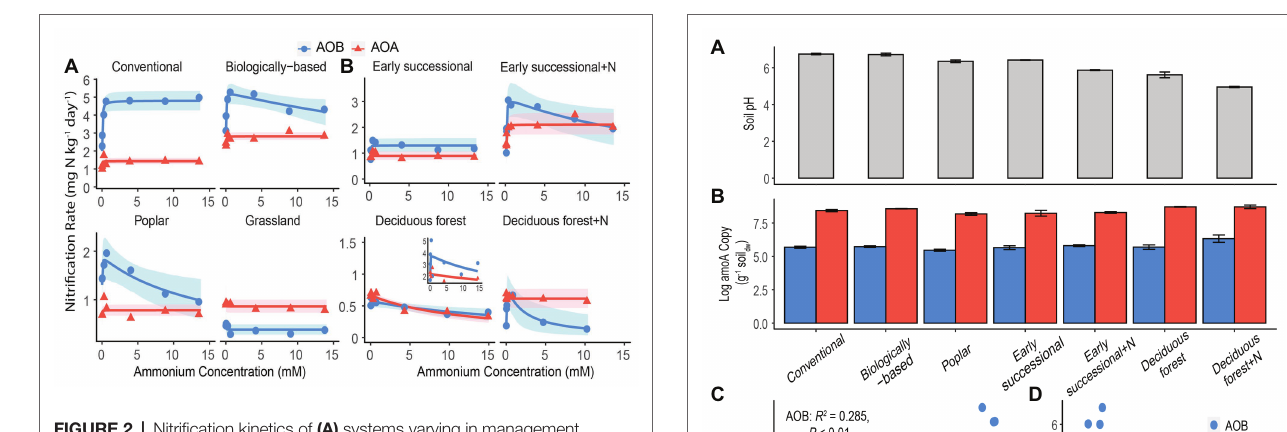
FIGURE 2 | Nitrification kinetics of (A) systems varying in management intensities and (B) unmanaged systems with (+N) or without long-term N fertilization; Michaelis-Menten or Haldane models were fit to AOB-derived (blue line) and AOA-derived (orange line) nitrification rates. Blue circles and orange triangles are the mean nitrification rates at each ammonium addition. Note y-axis scale differs by systems. Shading represents 95% bootstrap confidence intervals based on n = 3–4 field replicates except for Deciduous forest and its fertilized subplots where n = 2–3. Inset shows one removed replicate from Deciduous forest adjacent to a dairy farm. Ammonium addition ranged between 0.05 and 15 mM for Poplar and annual cropping systems because NO 3− + NO 2− accumulation at 0.01 mM cannot be reliably estimated; ammonium addition ranged between 0.01 and 10 mM for Fertilized Deciduous forest because NO 3− + NO 2− accumulation at 15 mM was too low to be detected. For all other systems, ammonium additions ranged between 0.01 and 15 mM.